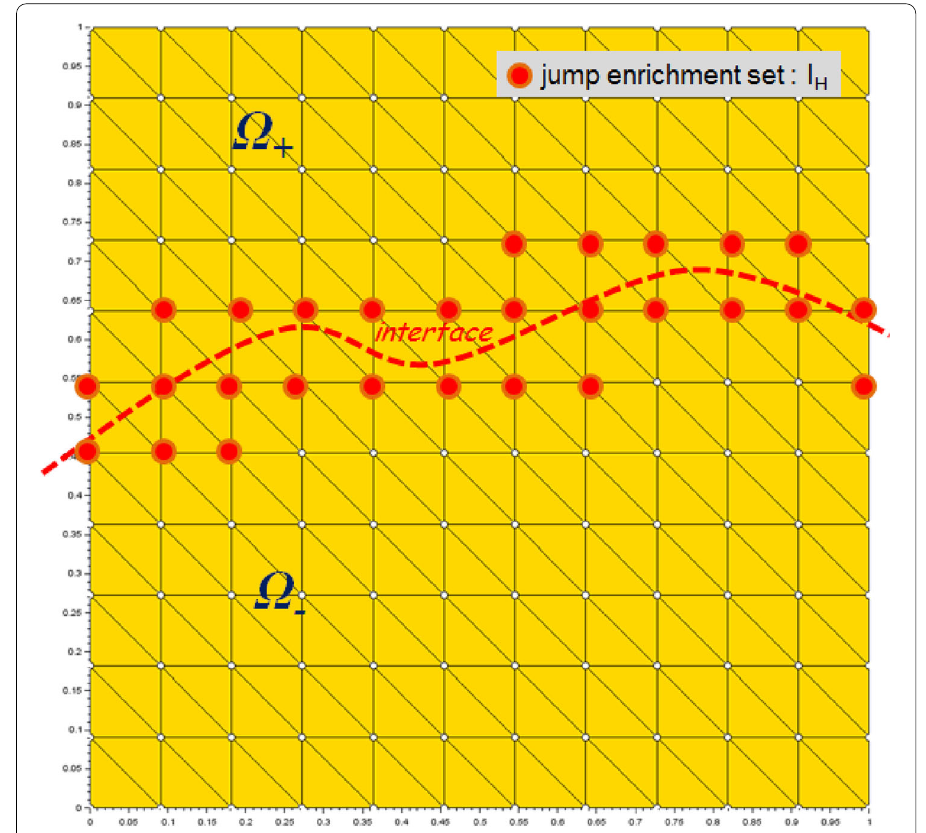
Fig. 3 Set of enriched nodes for a strong discontinuity. A node is enriched with the jump functions only if his support is cut by the crack’s